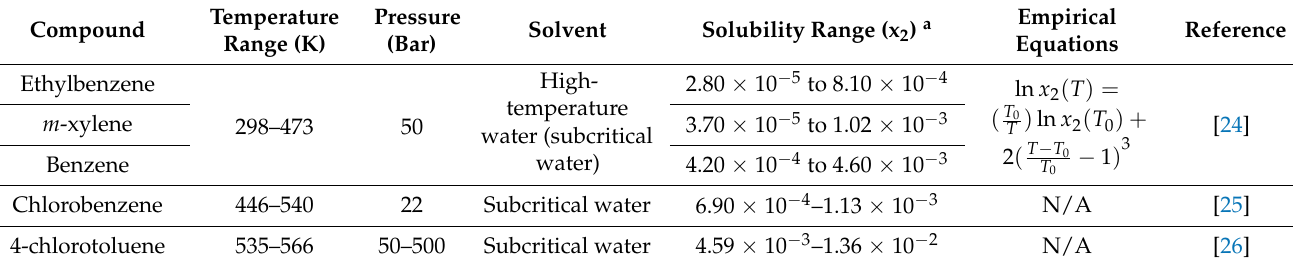
Table 2. Alkyl and Chlorobenzene solubilities in subcritical